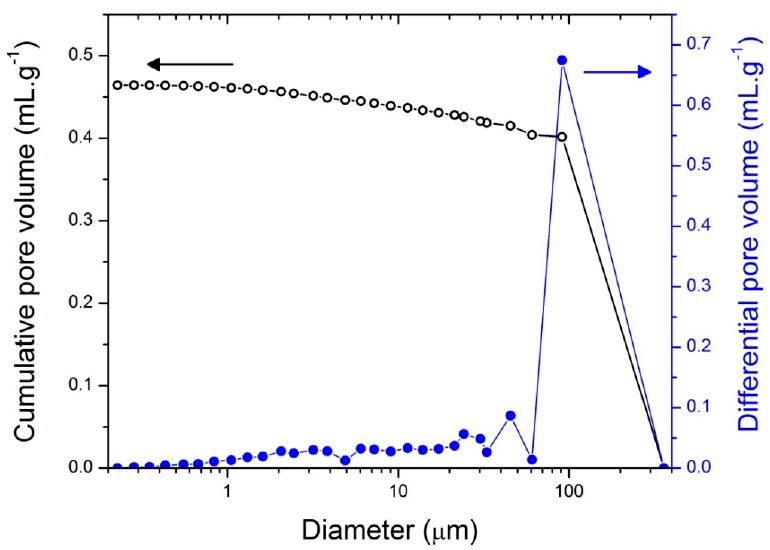
Figure 8. Pore size distribution of macroporous nanocomposites by mercury intrusion porosimetry.